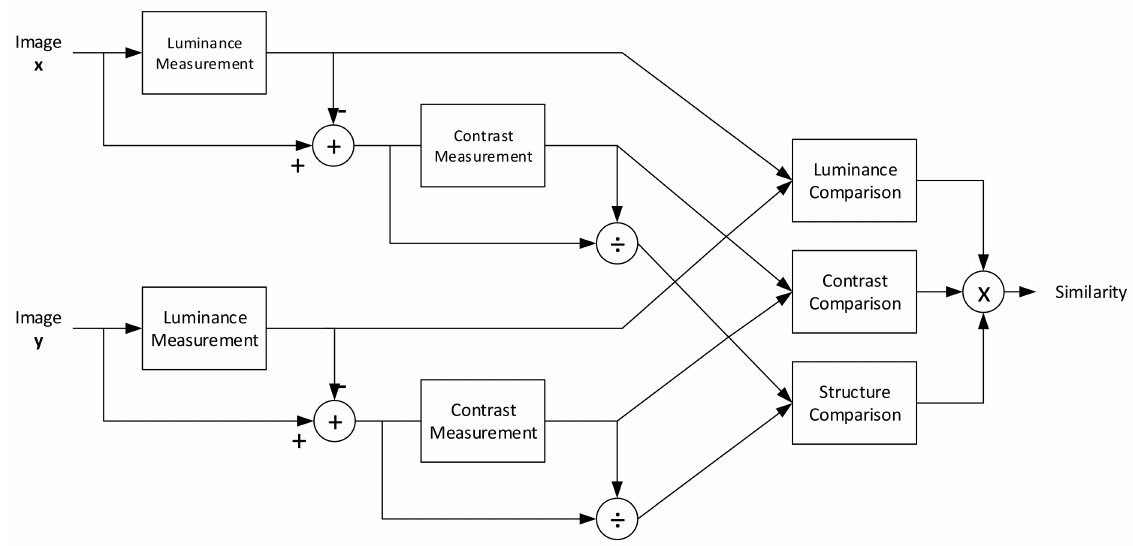
Figure 2. SSIM diagram to demonstrate the measurement